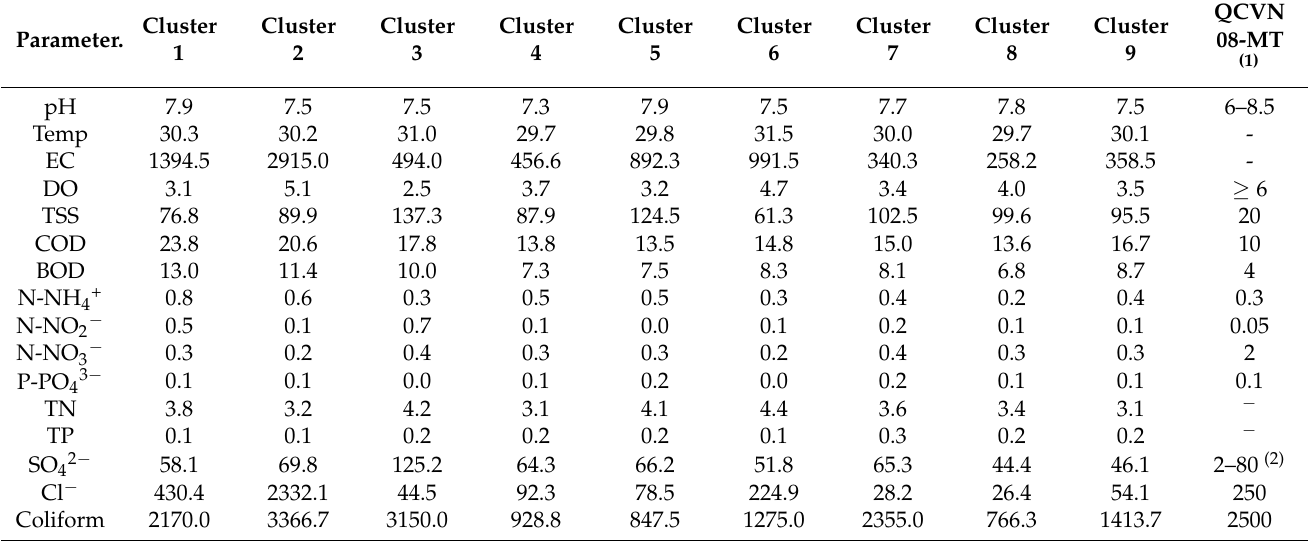
Table 2. Water quality in the